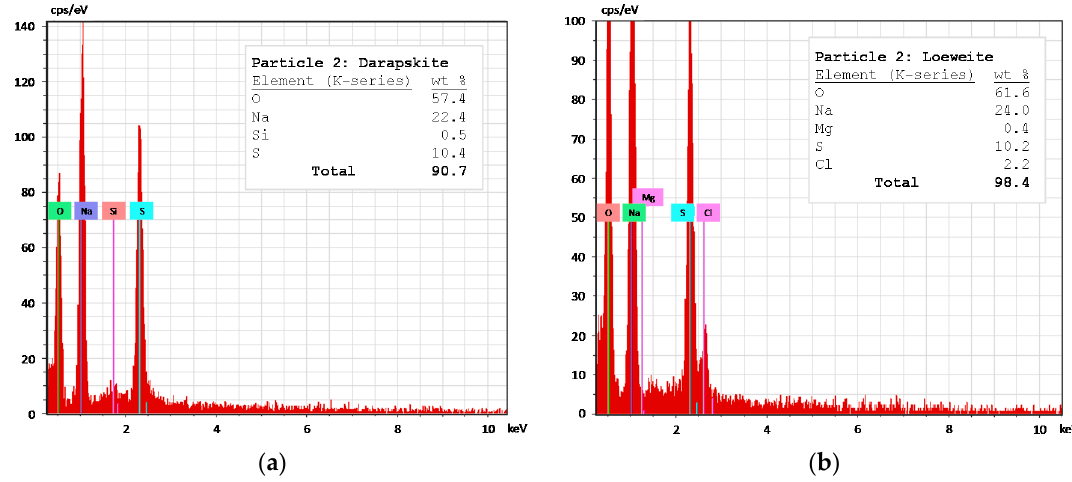
Figure A2. Spectrogram of ( a ) Darapskite and ( b ) Loeweite.